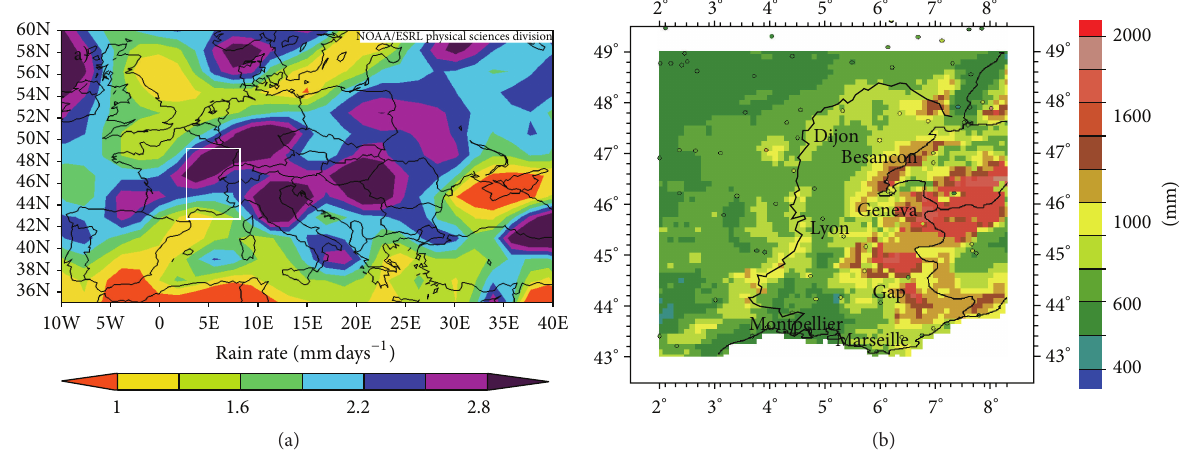
Figure 2: (a) Setting of the study area crossed by annual precipitation rates (1948–2014) via NOAA-ESRL NCEO Reanalysis, (b) with relative zoom of annual mean precipitation of Rhone region, as arranged from LocClim (http://www.fao.org/nr/climpag/pub/en0201 en.asp) via Inverse Distance Weighting with rainfall-elevation